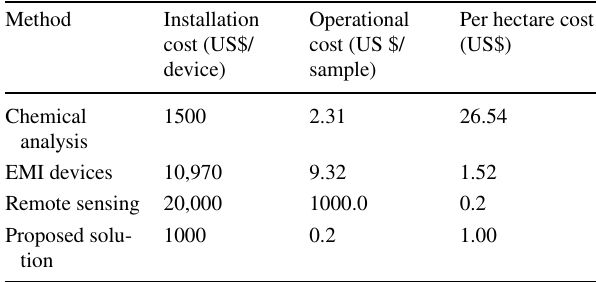
Table 5 Cost comparison of different solutions